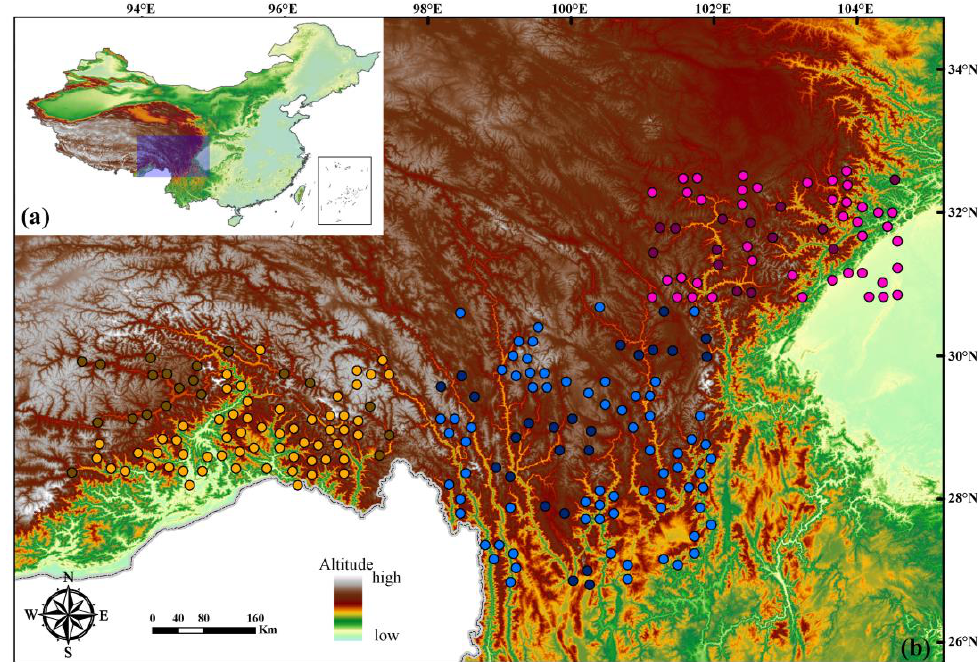
Figure 1. Distribution ranges of the three intraspecific lineages within Quercus aquifolioides . Points with dark yellow, blue, and pink represent the occurrences of lineages Tibet, WSP, and HDM, respectively. Points with yellow, blue, and pink represent the pseudo absences of lineages Tibet, WSP, and HDM, respectively.